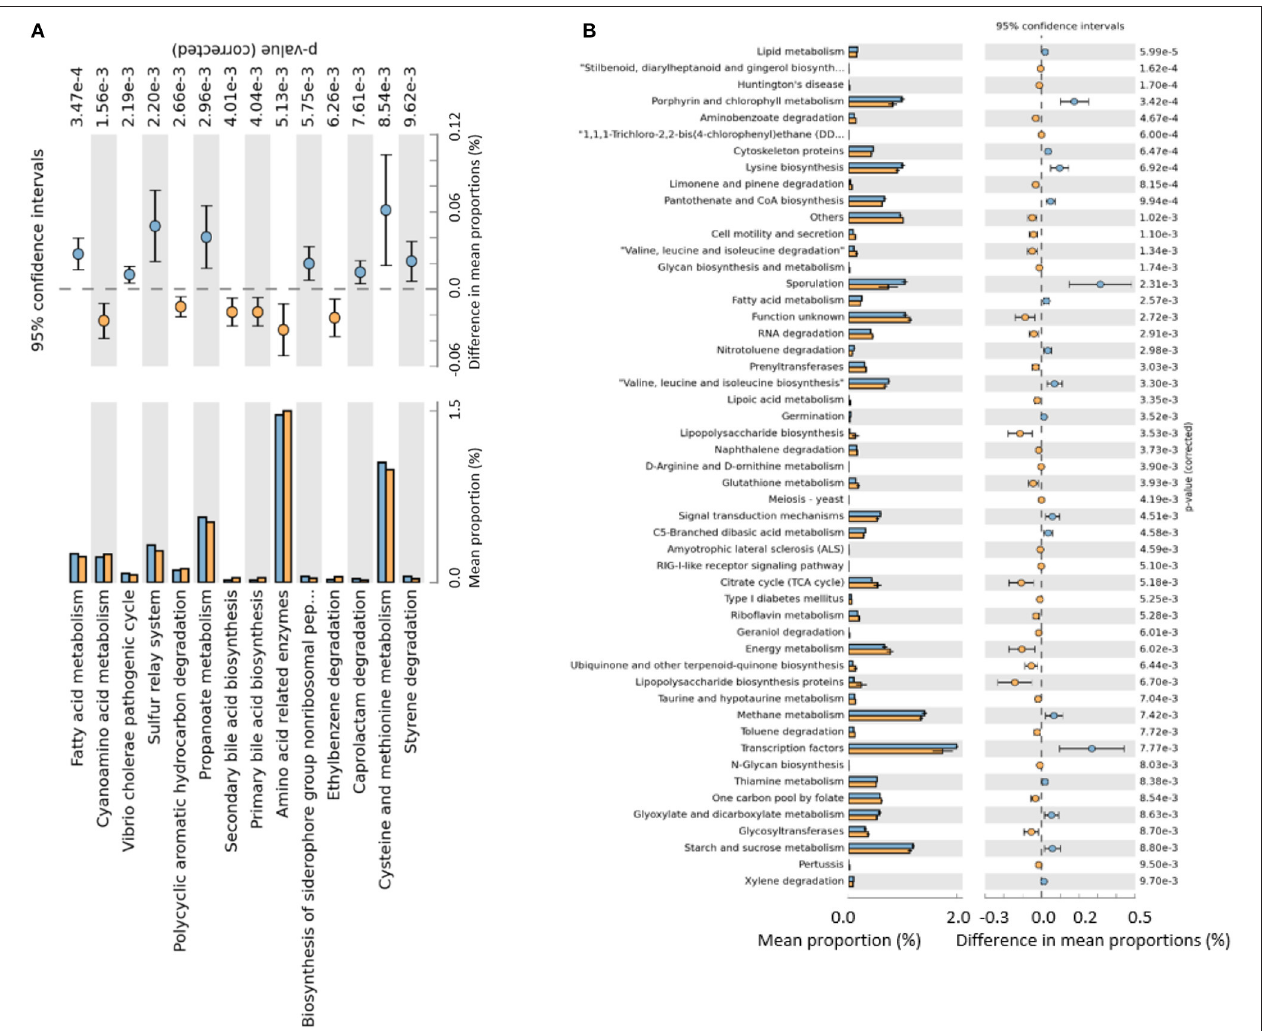
FIGURE 4 | Predicted functions of the cecal microbiota unique to the unchallenged control birds (A) and unique to challenged control birds (B) comparing 12 d (blue bars) vs. 21 d (orange bars) with P ≤